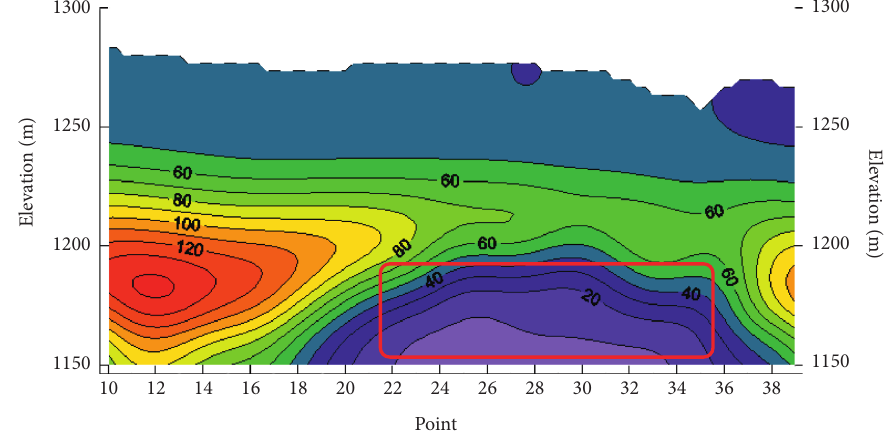
Figure 10: Apparent resistivity section of test section.